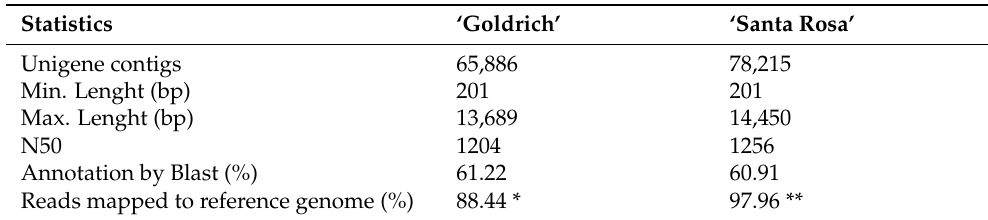
Table 4. Summary of statistics of de novo transcriptome assembly and gene annotation. De novo assembly was performed by Trinity software following the standard manual, and functional an-